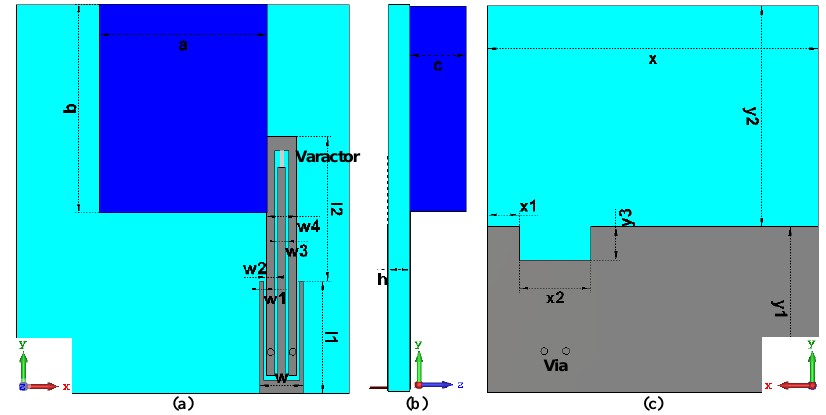
Figure 1. Configuration of the proposed tunable band-notched reconfigurable DRA: ( a ) top view; ( b ) side view; and ( c ) bottom view.